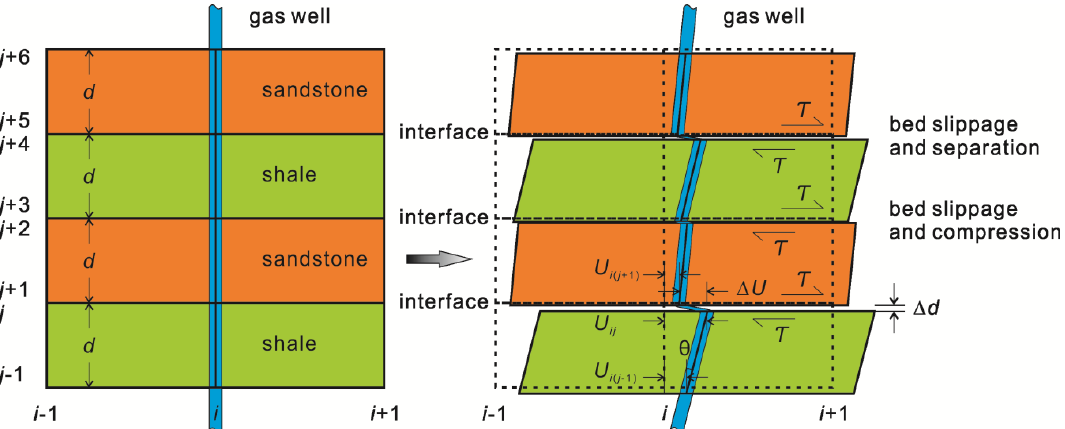
Figure 1. Typical deformation of an oil/gas well in and between layers of alternating soft rock and stiff rock as the well is distorted by longwall-induced movement (with slip interfaces between alternating layers) [3].